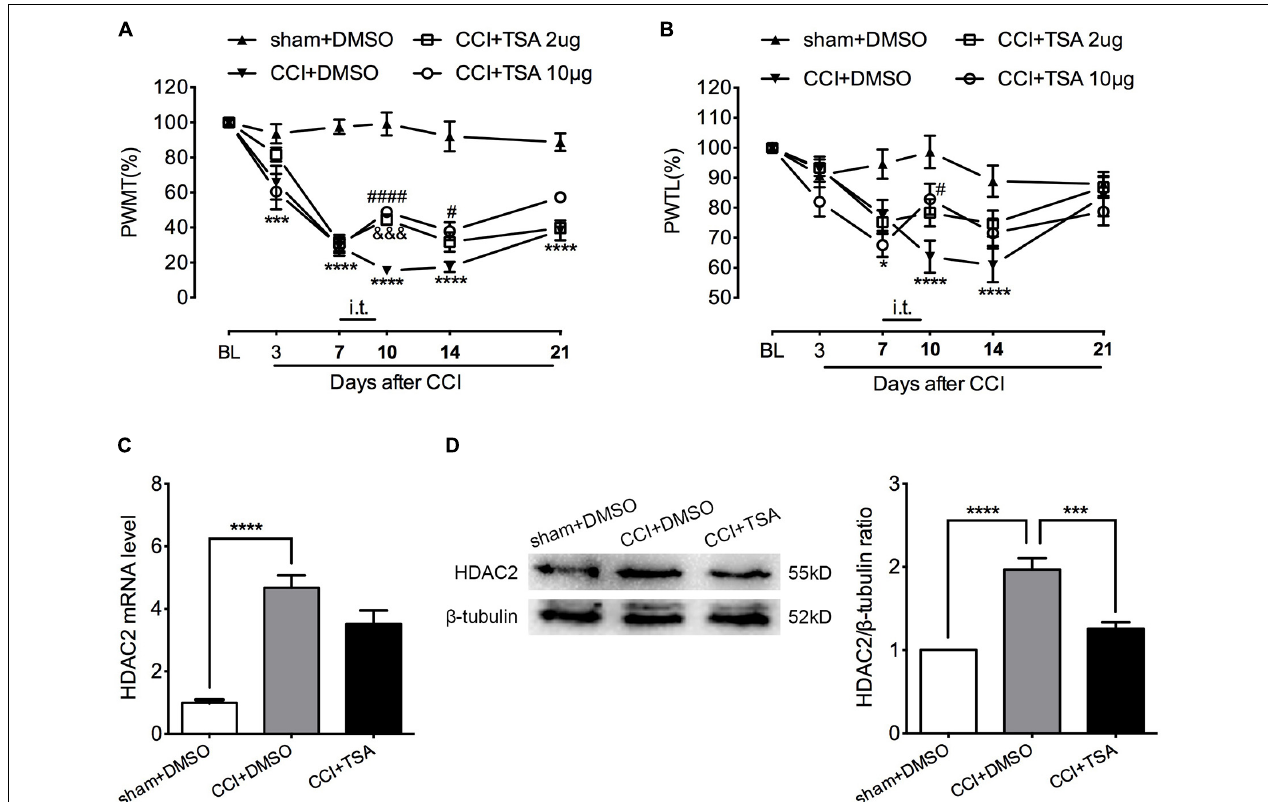
FIGURE 4 | Dose-dependent effect of TSA on mechanical and thermal threshold of CCI rats. (A) Intrathecal injection of TSA (once per day for three consecutive days starting at the seventh day) partially reversed the decrease in mechanical threshold in CCI rats. The analgesic effect was obvious on days 10 and 14 post-injury in the 10 µ g group ( n = 6 per group). In the 2 µ g group, the effect was only significant on day 10 post-injury. ∗∗∗ p < 0.001, ∗∗∗∗ P < 0.0001, CCI+DMSO vs. sham+DMSO; # p < 0.05, #### p < 0.0001, CCI+TSA 10 µ g vs. CCI+DMSO; &&& p < 0.001, CCI+TSA 2 µ g vs. CCI+DMSO; BL, baseline; PWMT, paw withdrawal mechanical threshold. (B) Repeated daily intrathecal injection of TSA partially reversed the decreased thermal threshold at day 10 after CCI in the 10 µ g group ( n = 6 per group). ∗ p < 0.05, ∗∗∗∗ p < 0.0001, CCI+DMSO vs. sham+DMSO; # p < 0.05, CCI+TSA 10 µ g vs. CCI+DMSO; PWTL, paw withdrawal thermal latency. (C,D) Repeated intrathecal injection of TSA (10 µ g) daily suppressed HDAC2 protein expression but not mRNA level in the lumbar spinal cord of CCI rats; n = 4 per group, ∗∗∗ p < 0.001, ∗∗∗∗ p <